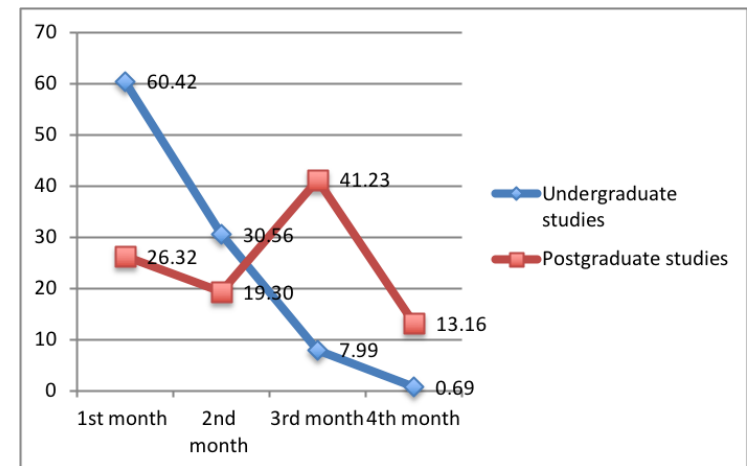
Figure 4 . Time analysis of discussion board participation (percentages).